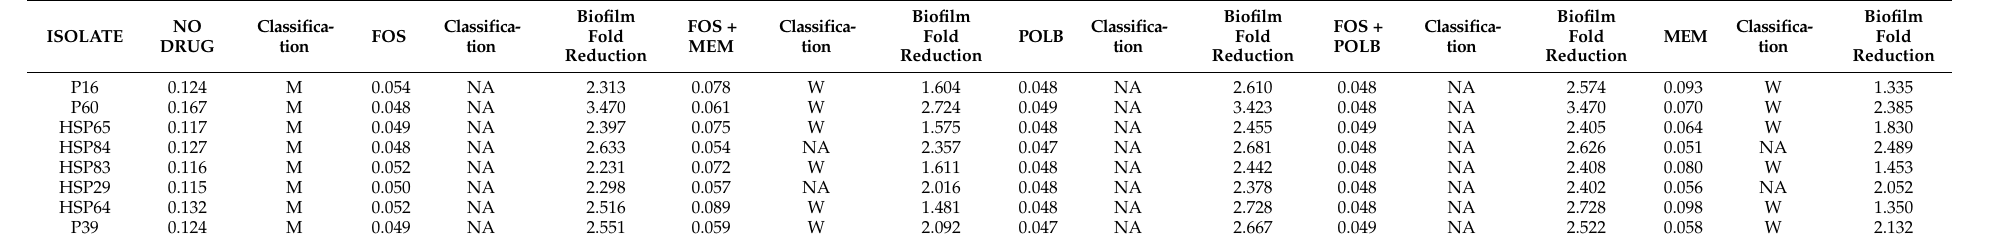
Table 5. Biofilm assay results showing the optical densities values for each isolate at each different exposure to antimicrobials and